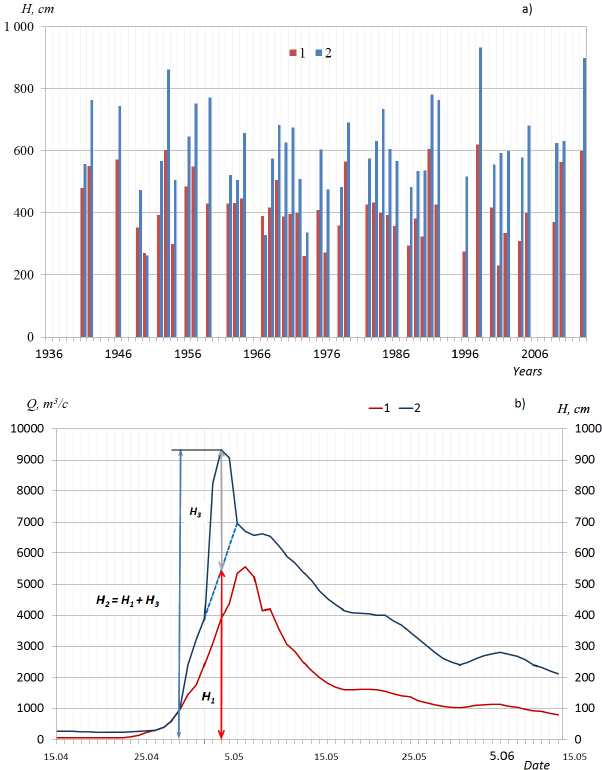
Figure 2. Changes in the flow component H 1 (1) and maximum wa- ter levels H 2 (2) in years with ice jams ( H 3 is the ice jam component of water level) (a) and scheme of its identification in the case of the flood in 1998 (changes in water level (1) and water discharge (2) for Sukhona River near Velikiy Ustyug) (b)